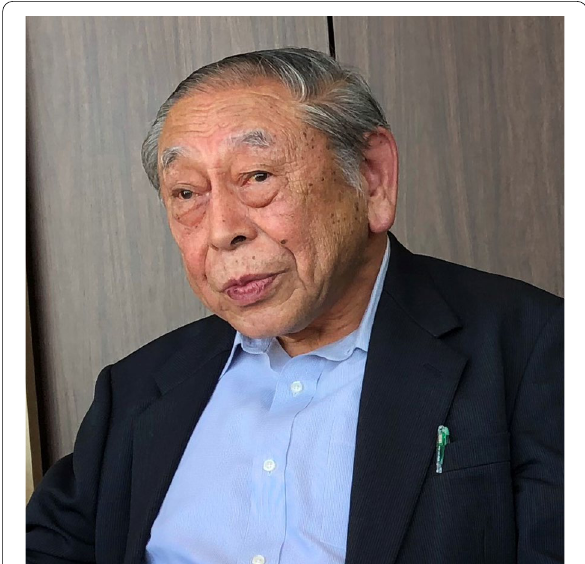
Fig. 22 Shun-ichi Udagawa in a restaurant, Tokyo, Japan, November 2018. Photo: T.